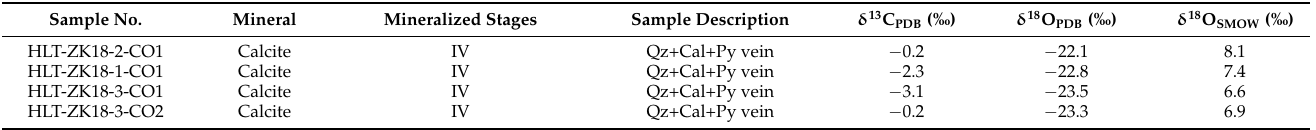
Table 3. C and O isotope data of calcite samples from the Huoluotai Cu (Mo) deposit. Sample No.